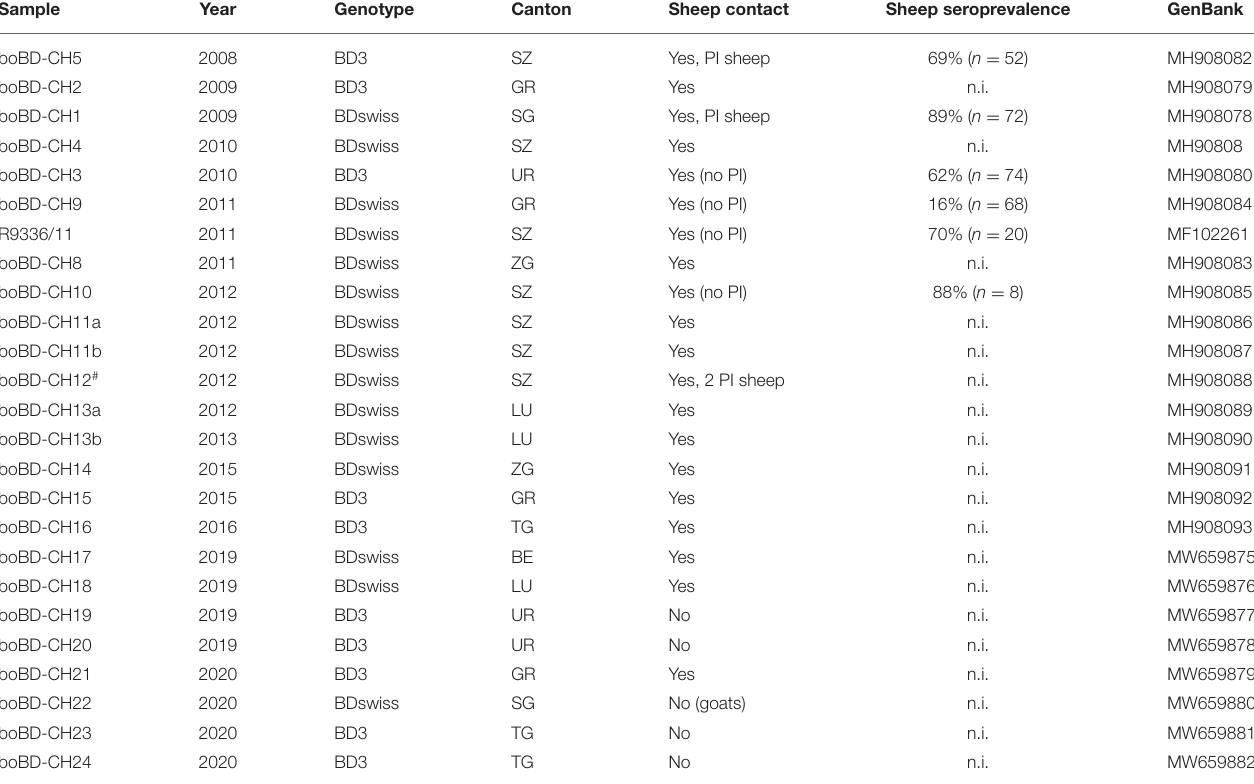
TABLE 2 | Cattle persistently infected with BDV identified in Switzerland since the start of the BVD eradication in 2008 until the end of 2020.